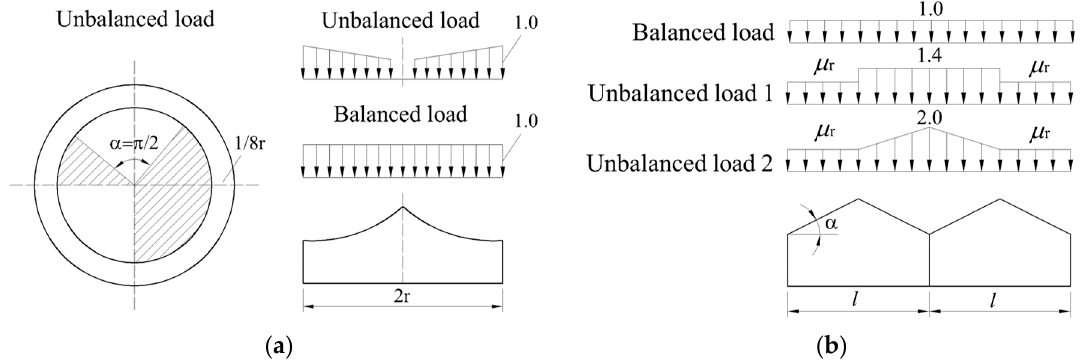
Figure 10. Unbalanced distributed shape coefficient on building roofs: ( a ) shape coefficient for umbrella-shaped roof indicated in the technical specification for cable structures; ( b ) shape coefficient for multi-span gable roof indicated in load code for design of building structures.